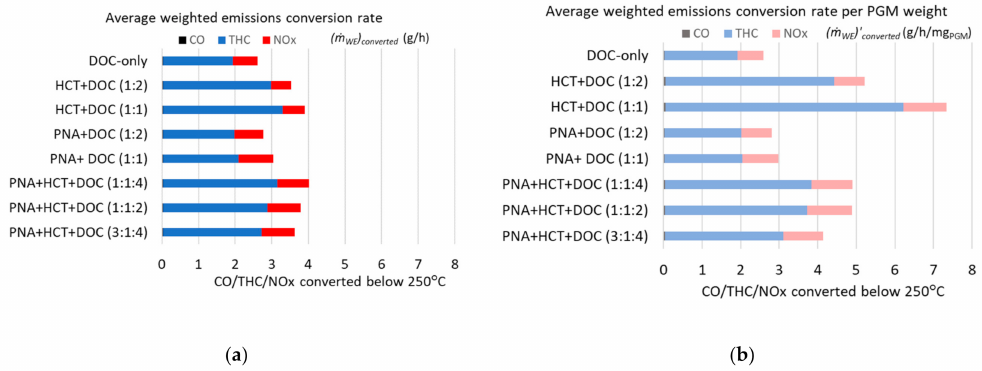
Figure 4. ( a ) Average weighted emissions conversion rate up to 250 ◦ C, as calculated from the parameters in Table 1 and Equations (1) and (2), for a series of physical mixture reactor beds; ( b ) also shows the emissions when normalized to PGM content. Contributions from ( (cid:4) ) CO, ( (cid:4) ) THC, and ( (cid:4) ) NOx are shown as a portion of the total for each graph. Ratios in parentheses represent the mass ratio of the different components in the sample, respectively.